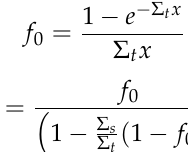
of the gold foils, as shown in Equation